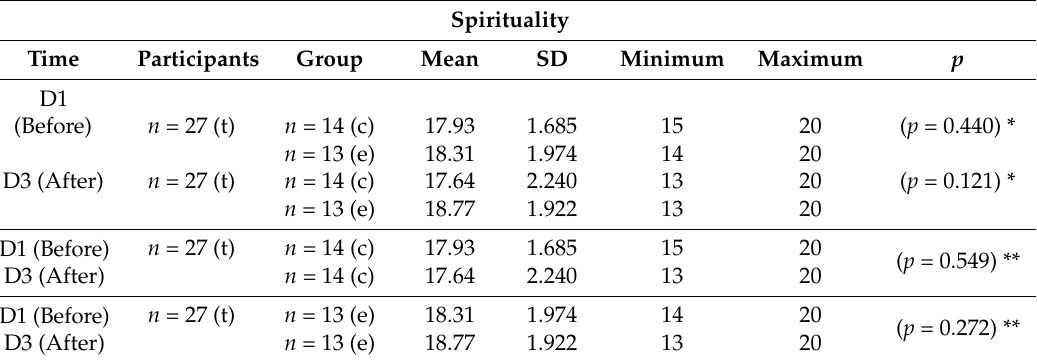
Table 2. Spirituality Scores.